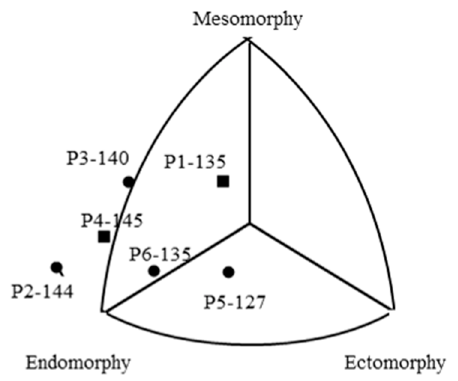
Figure 2. The individual somatoplots of the studied persons (P1–6, the numbers after the hyphens indicate the individual M values in Wm − 2 , ■ : male subjects, ● : female subjects). indicate the individual M values in Wm − 2 , (cid:4) : male subjects, • : female